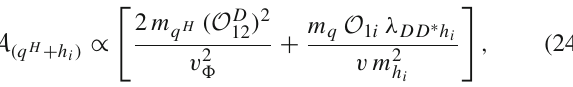
Fig. 3 Dominant Feynman diagrams relevant for coannihilation in TeV